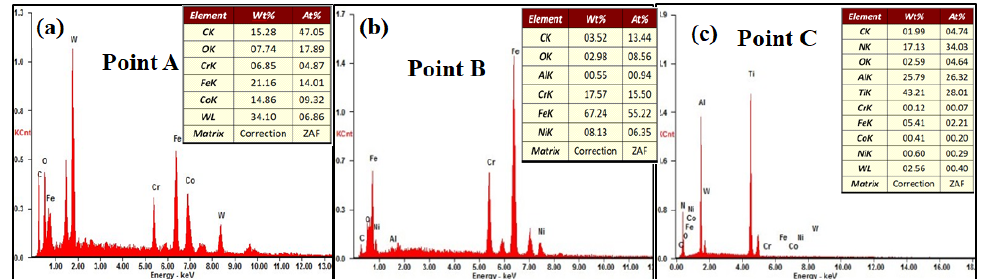
Figure 7. The EDS results of TiAlN coated cemented carbides after stainless steel turning: ( a ) Point A, ( b ) Point B and ( c ) Point C.